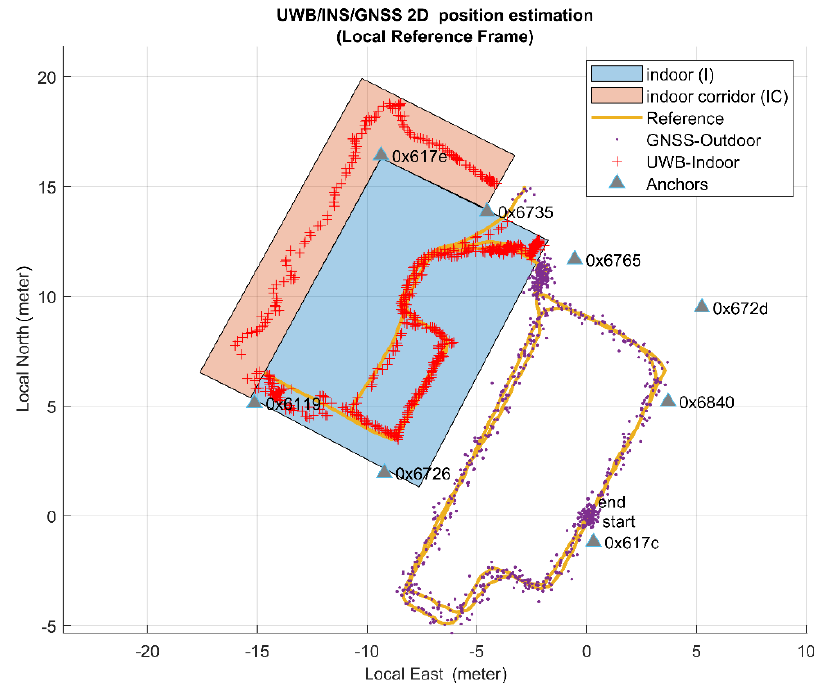
Figure 9. Pedestrian trajectory obtained by the proposed algorithm expressed in WGS84-UTM zone 32 N coordinates.